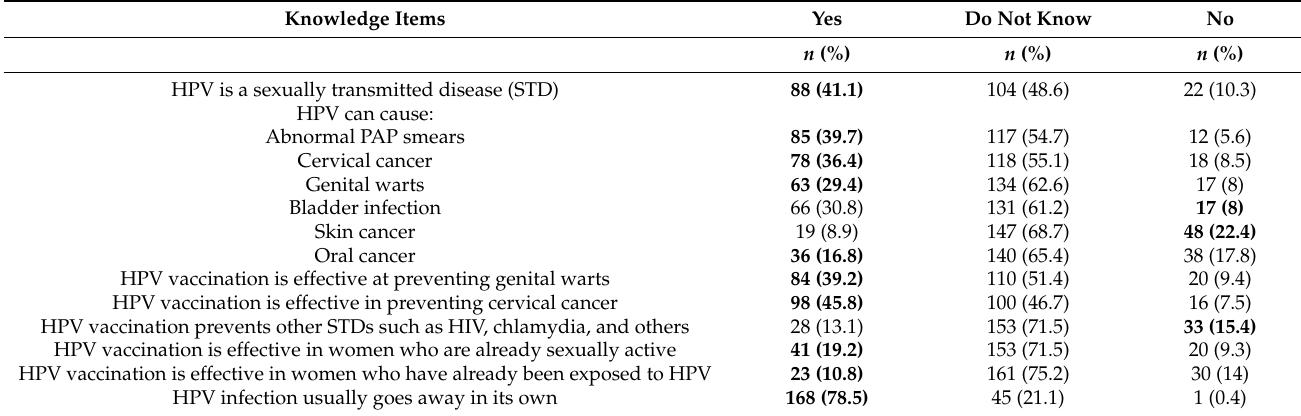
Table 1. Knowledge about HPV infection and cervical